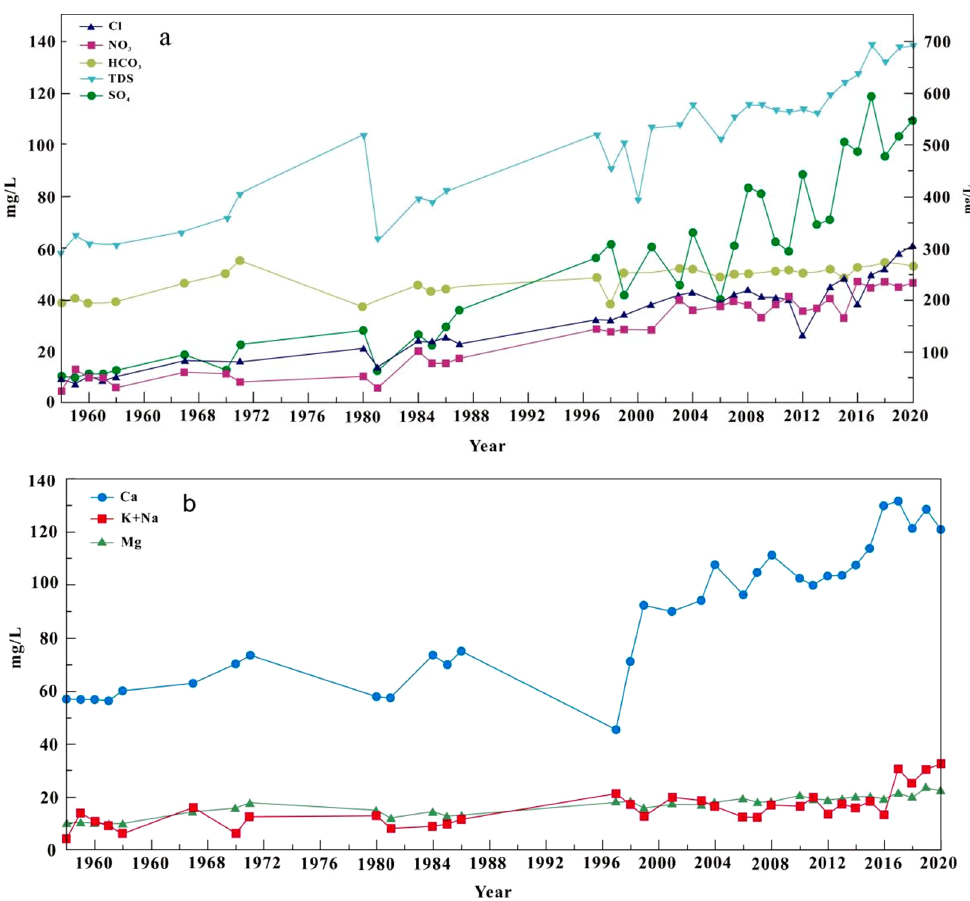
Figure 10. Variation of major ions (( a ) TDS, Cl, NO 3 , HCO 3 , SO 4 ; ( b ) Ca, K+Na, Mg) in Baotu Spring water from 1958–2020. TDS and HCO3 look at the right axis.